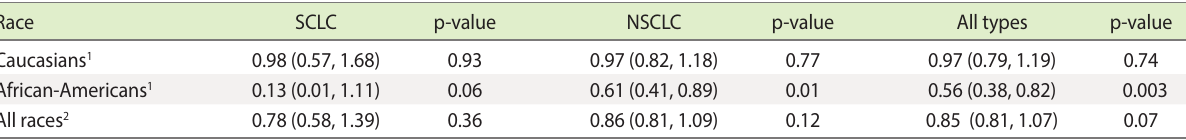
Figure 2. Kaplan-Meyer curve of lung cancer free sur- vival in different races. (A) Lung cancer free survival in all races. (B) Lung cancer free survival in Caucasians. (C) Lung cancer free survival in